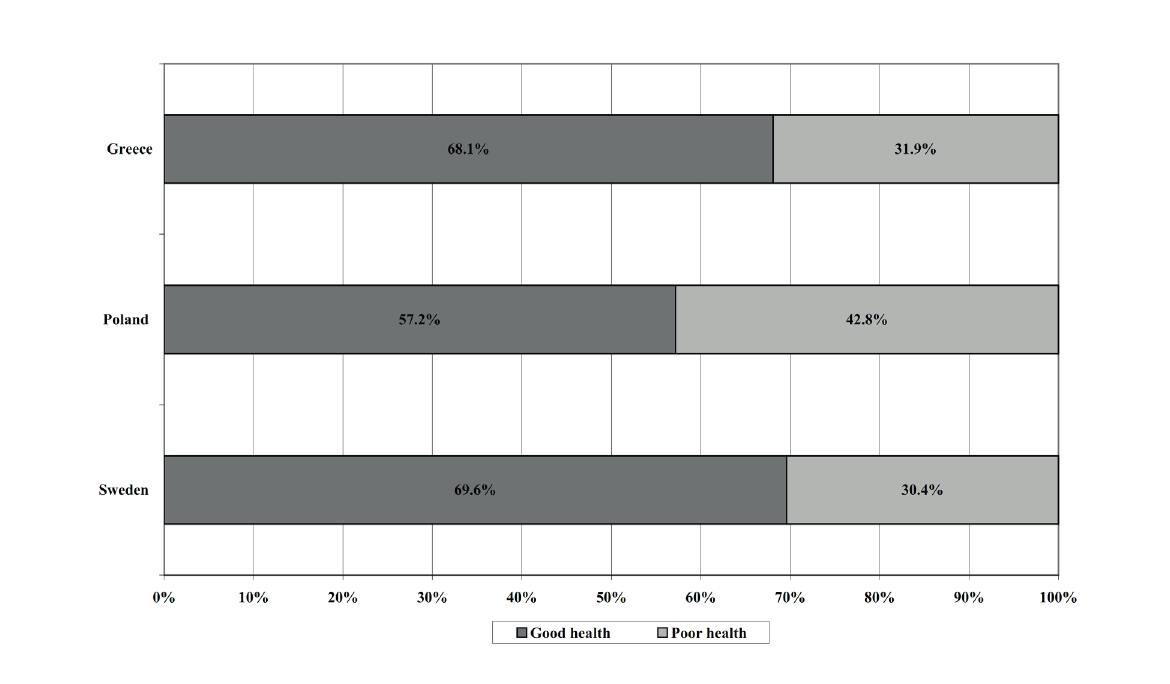
Figure 1. Self-rated health (%) in Sweden, Greece and Poland (LIVEWHAT,